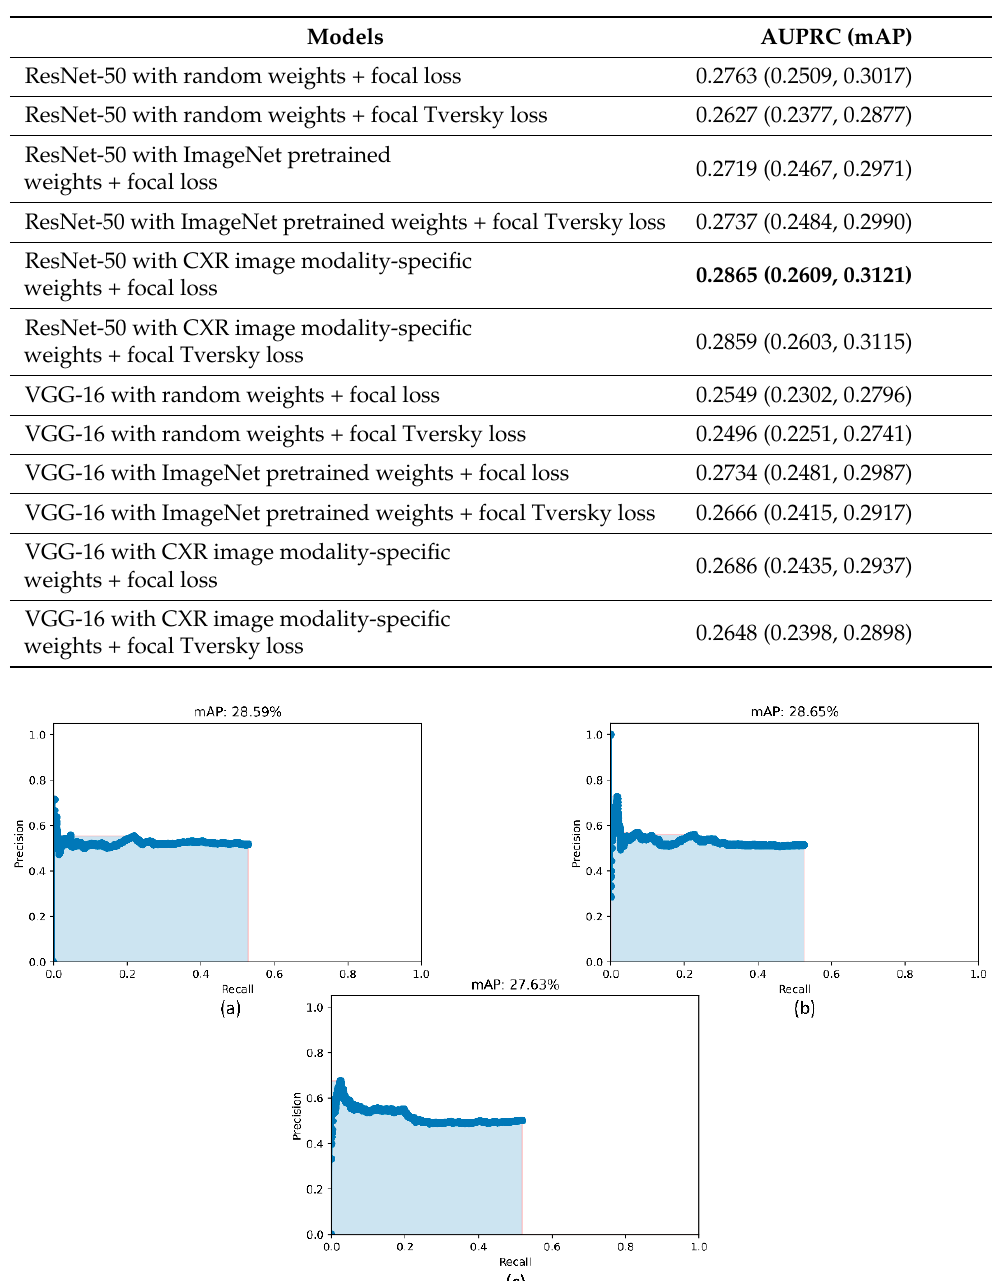
Table 4. Performance of RetinaNet with the varying weight initializations for the classifier backbones and training losses. The values in parenthesis denote the 95% CI for the mAP metric. Bold numerical values denote superior performance.